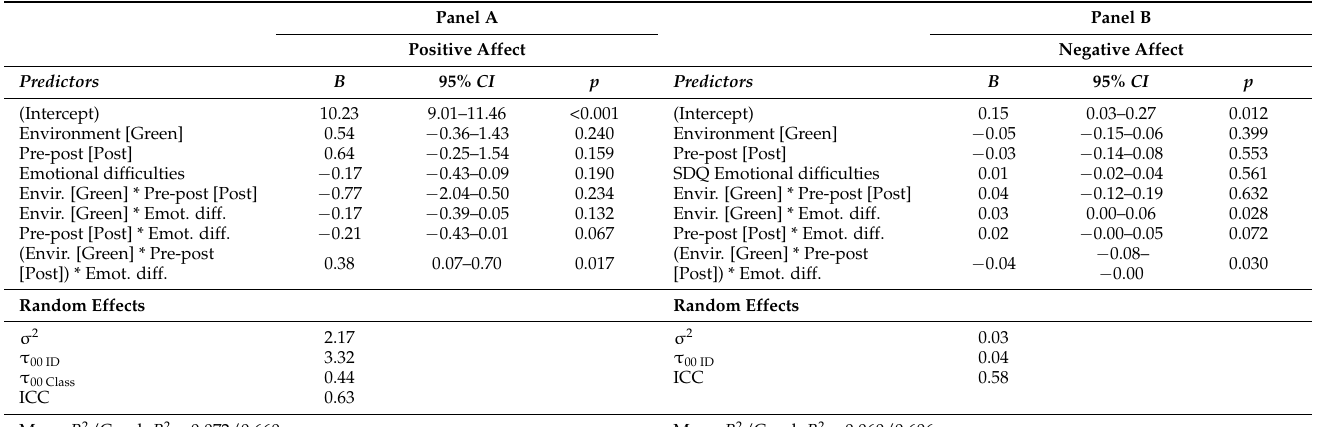
Panel B Table 4. Linear mixed models for pre ‐ post positive and negative affect.